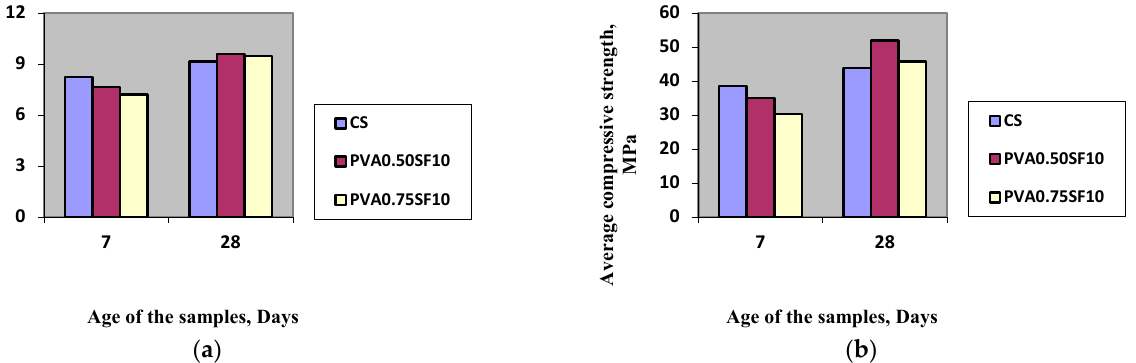
Figure 7. Compressive and bending strengths of mortar containing PVA fiber and optimum percentage of SF.